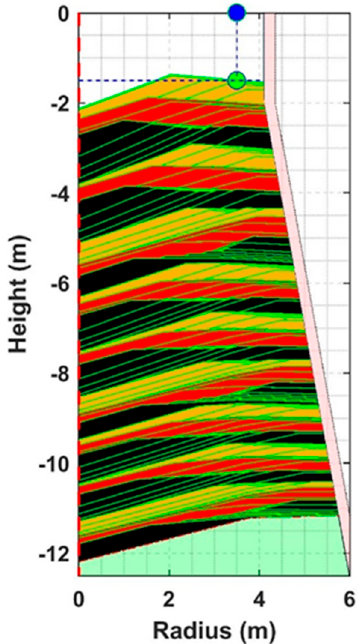
Figure 12. Radial stock profile before (red) and after (blue) each dump simulated by the model. Dashed lines show the corresponding position of the uppermost layer just before the next layer is charged.